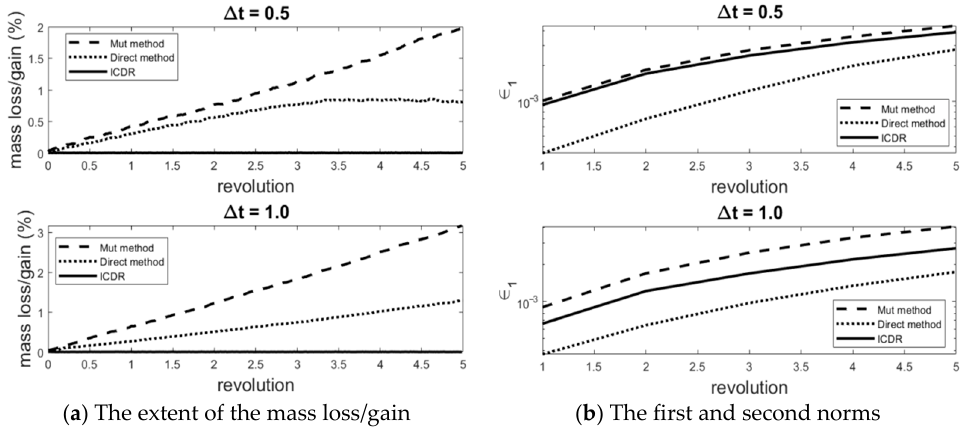
Figure 8. Comparison of the mass loss/gain and the norm values for different methods.